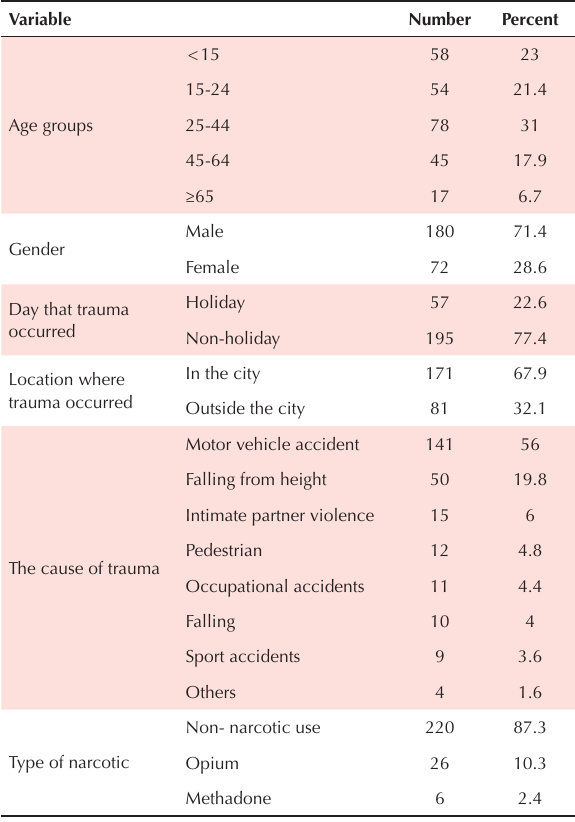
Table 1. Demography frequency distribution of traumatic